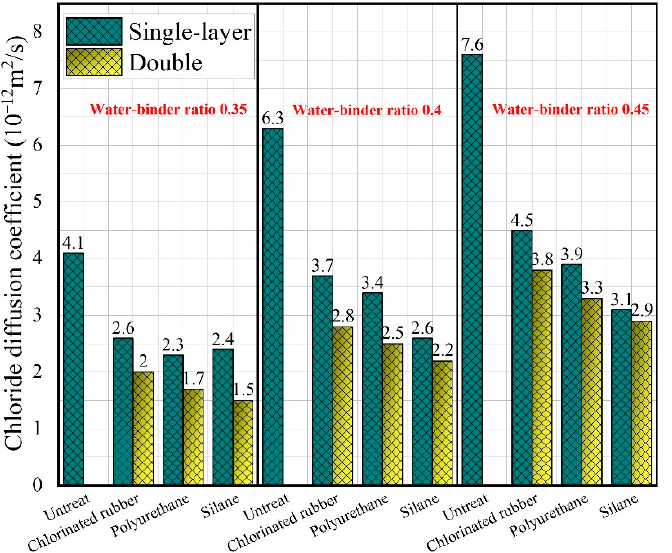
Figure 12. Chloride ion diffusion coefficient of the composites with different water–binder ratios coated by different layers.